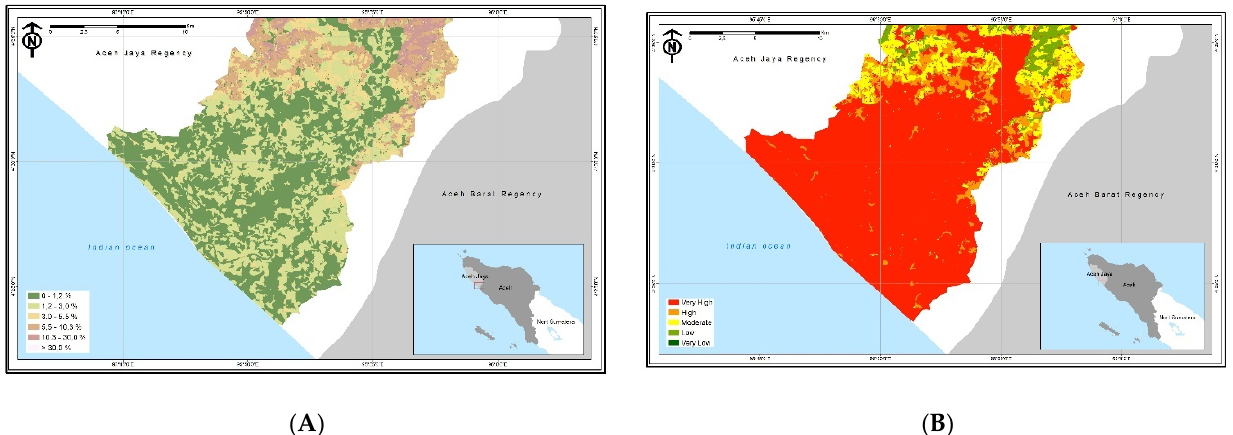
Figure 7. Topographic map (elevation and slope) of Krueng Teunom and its relation to flood disasters: ( A ) elevation and slope map and ( B ) flood risk map.